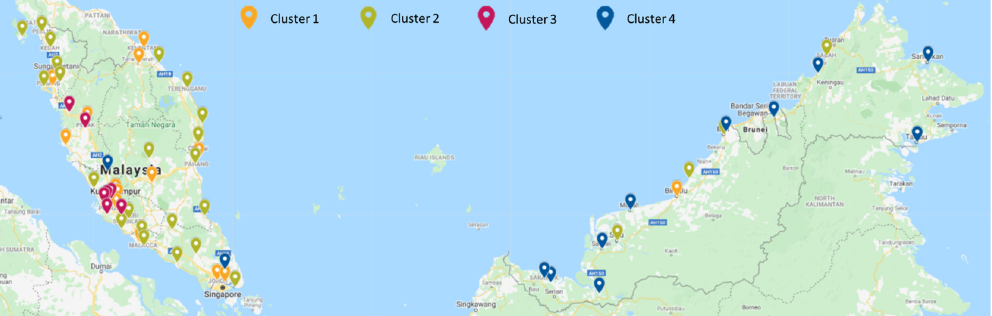
Figure 9. Air monitoring stations’ locations colored according to clusters for PM 10 daily average time series data with DTW and k-Means as its clustering algorithm.